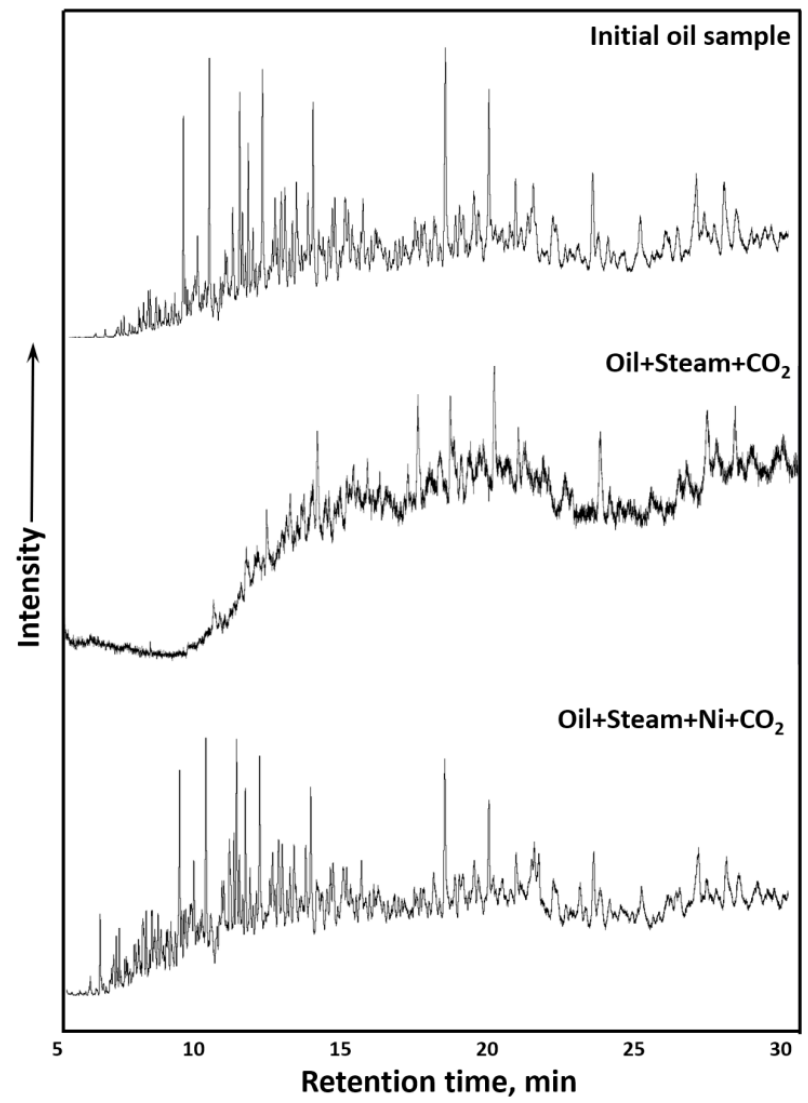
Figure 5. GC-MS spectra of the fractions of aromatics.